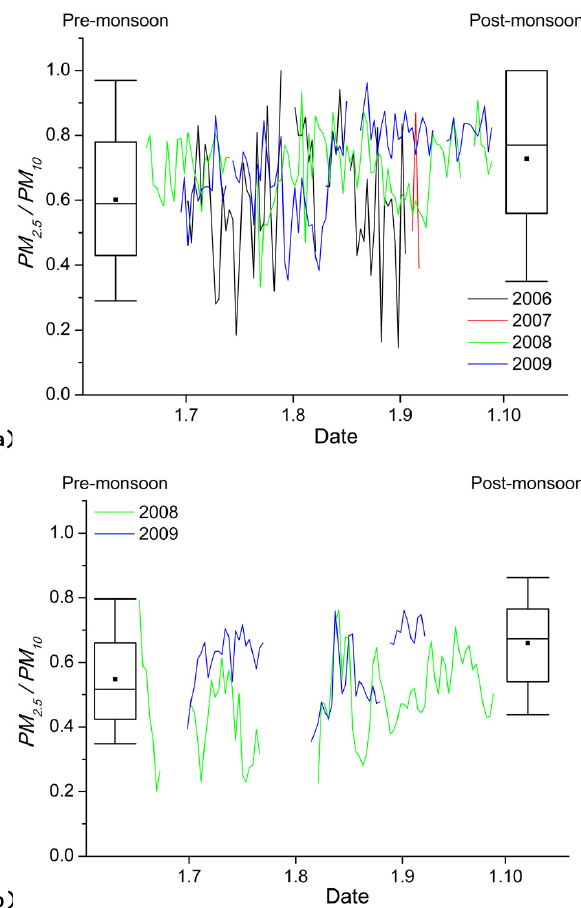
Fig. 10. Fraction of equivalent black carbon (BCe) in PM 2 . 5 mass. (a) Mukteshwar (b) Gual Pahari. Lines are 24h running averages from the monsoon season, box plots denote to the pre- and post- monsoon seasonal values of 10%-ile, 25%-ile, median (line), aver- age (dot), 75%-ile, and